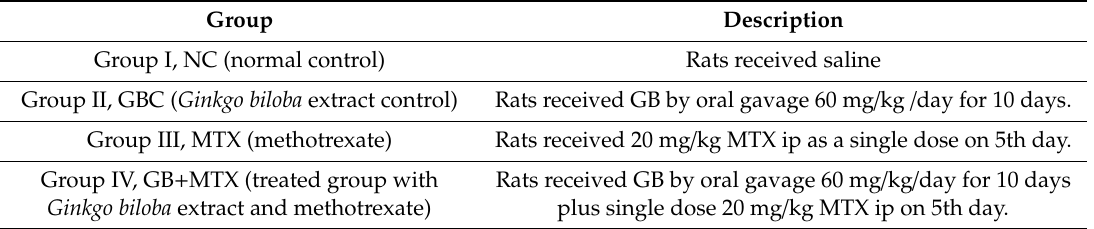
Table 1. Experimental groups and treatment protocol in our